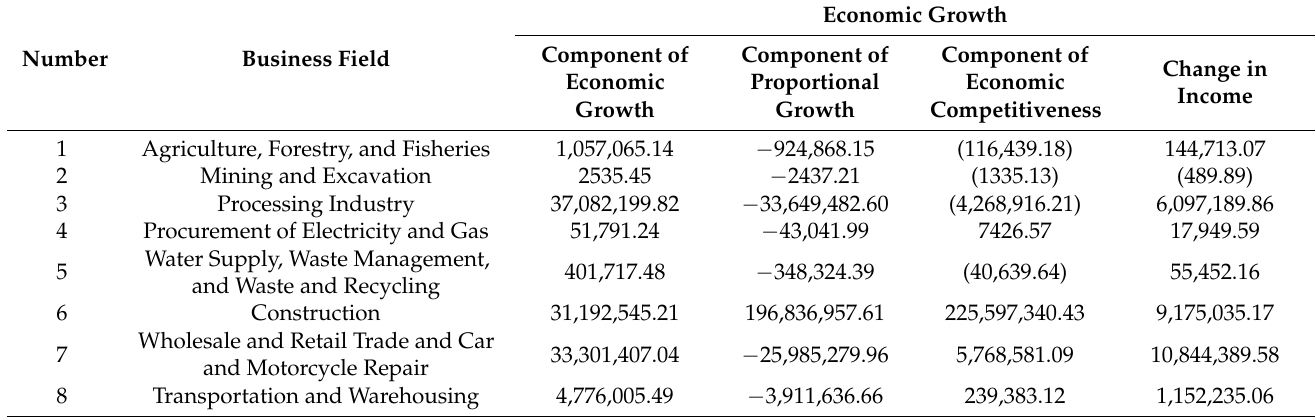
Table 4. The economic growth of Makassar